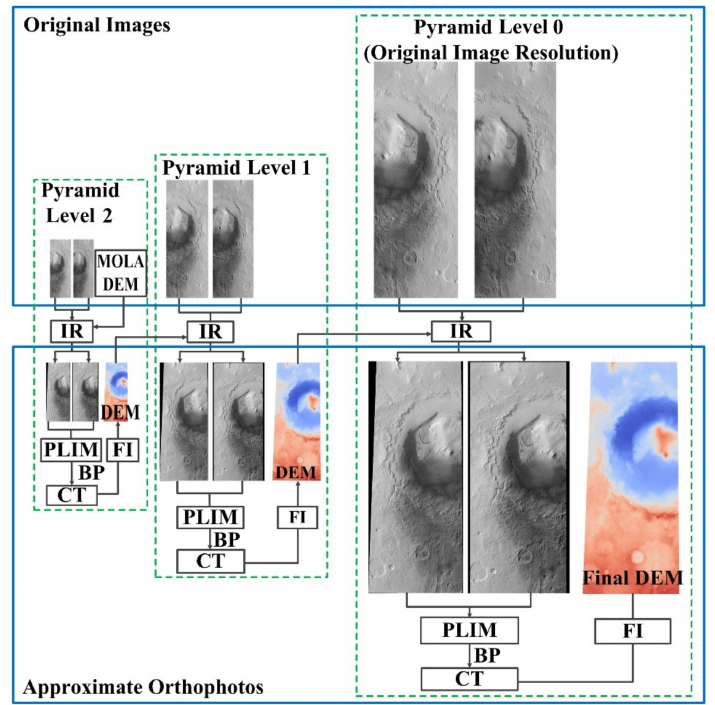
Figure 5. The basic principle of the proposed pixel-level image matching method. MOLA: Mars Orbiter Laser Altimeter; DEM: digital elevation model; IR: image rectification; PLIM: pixel-level image matching; BP: back-projection; CT: coordinate transformation; FI: forward